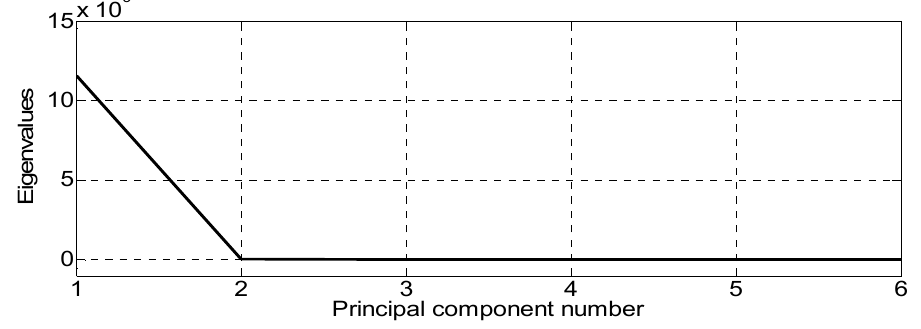
Figure 20. SCREE plot of the first 6th eigenvalues.